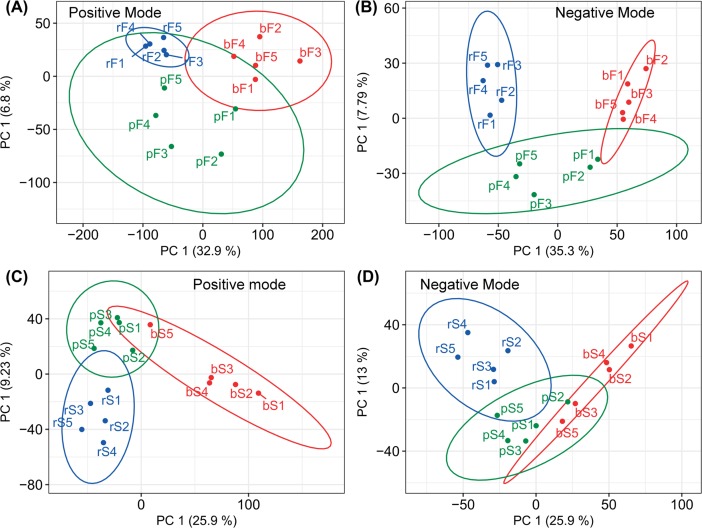
Score plots for the PLS-DA results.The score plots based on the first two components derived from the PLS-DA results for the leaf tissues analyzed in positive and negative ion modes were presented as (A) and (B), respectively. The score plots based on the first two components derived from the PLS-DA analysis results for the sheath tissues analyzed in positive and negative ion modes were presented as (C) and (D), respectively. The first two components in the PLS-DA models (A), (B), (C) and (D) explained 50.6%, 43.1%, 35.1% and 38.9% of the total variances, respectively. Samples bF 1–5, pF 1–5 and rF 1–5 were from the control, the phenylacetic acid and R. solani treated leaf tissues, respectively. Samples bS 1–5, pS 1–5 and rS 1–5 were from the control, the phenylacetic acid and R. solani treated sheath tissues, respectively.